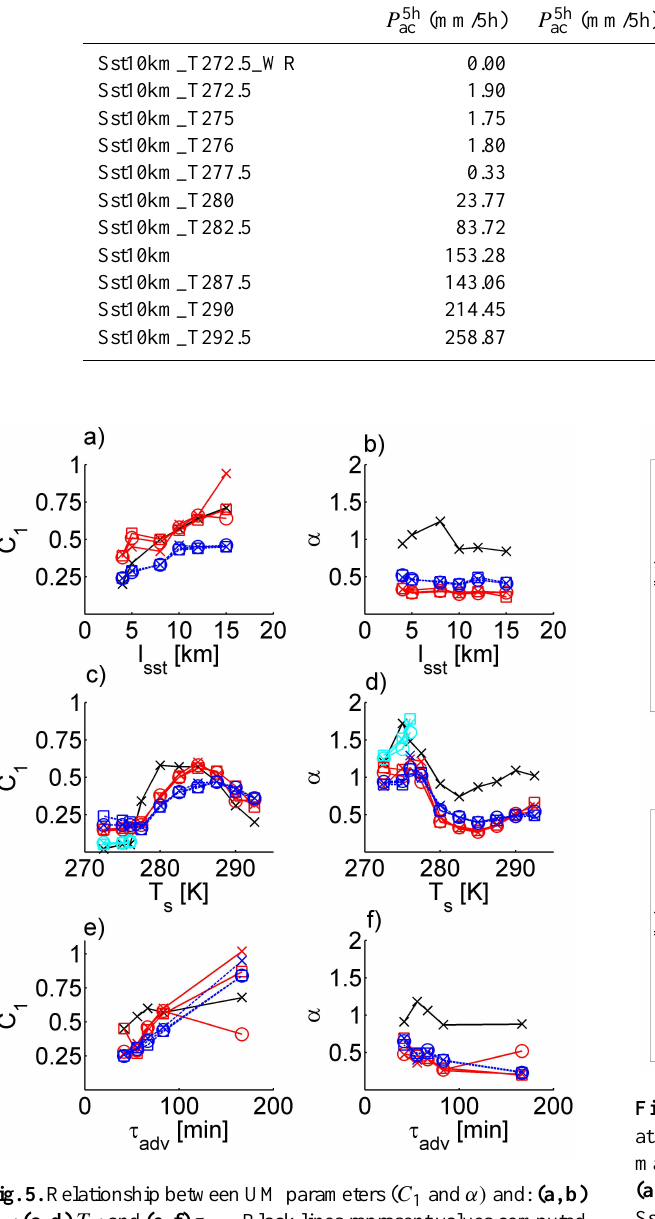
Table 3. Local maximum of P 5h ac , q c and q i fields and domain total P 5h ac for simulations with different temperature profiles. Simulation Local maximum of Total domain Local maximum of Local maximum of